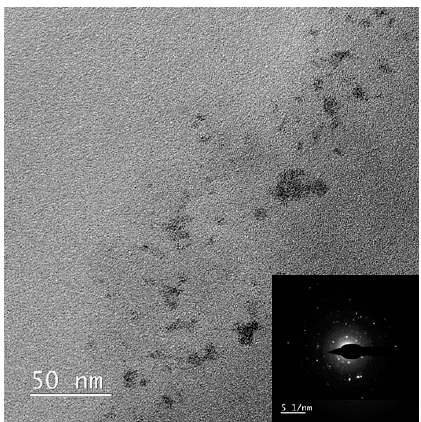
Figure 8. The TEM photomicrograph of the Re@NCat after the 11th catalytic run.